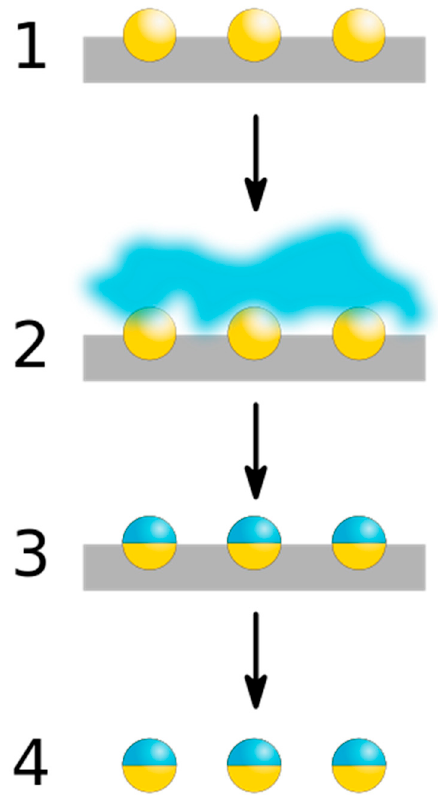
Figure 6. Schematic representation of the crucial steps in the masking technique to form Janus particles. (1) Exposure of a hemisphere of homogeneous nanoparticles; (2) Application of masking techniques; (3) Chemical modification of particle properties via masking process; and (4) Removal of the masking agent, resulting in Janus particle formation.